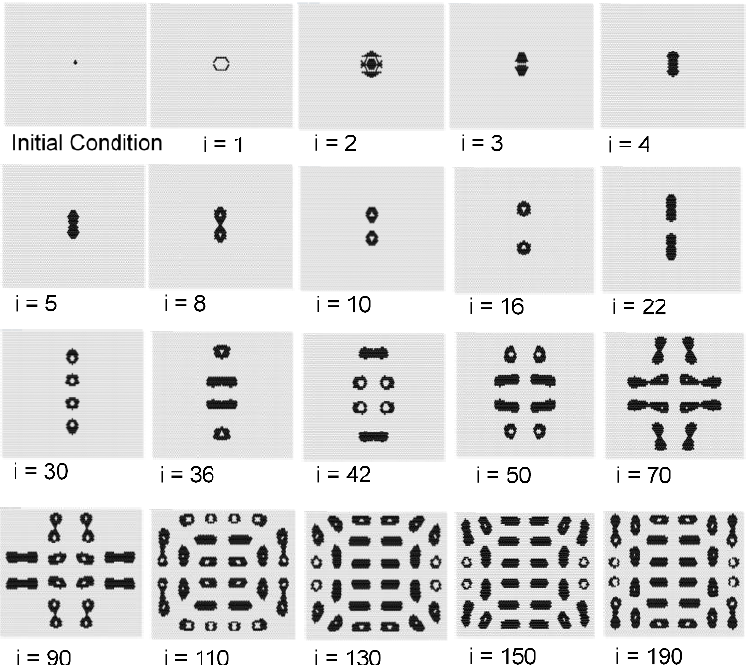
Figure 12. Results for the model with s = 4, t = 8, w 1 = 0.40, and w 2 = 0.75 in a hexagonal grid. As the initial condition, four state 1 cells (black) were set in the center of the field as shown in Figure 7. The central spotted pattern was divided into two spots, which then spread until the field was filled with spotted patterns.